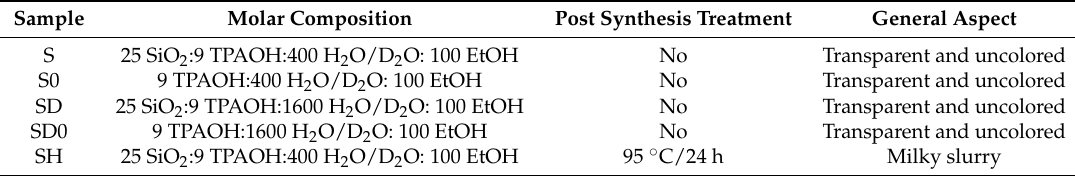
Table 1. Characteristics and mixture composition of samples investigated.